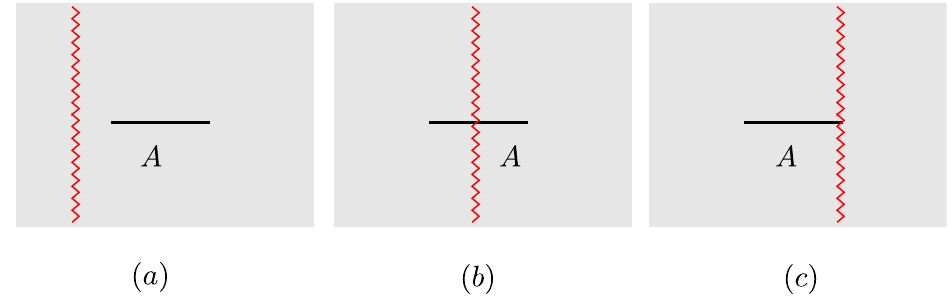
Figure 1 . The three possible positions of defects. The black line denote the interval A and the red zigzag line stands for the defect. In this paper, we consider the case (b) where the defect sits in the interval A